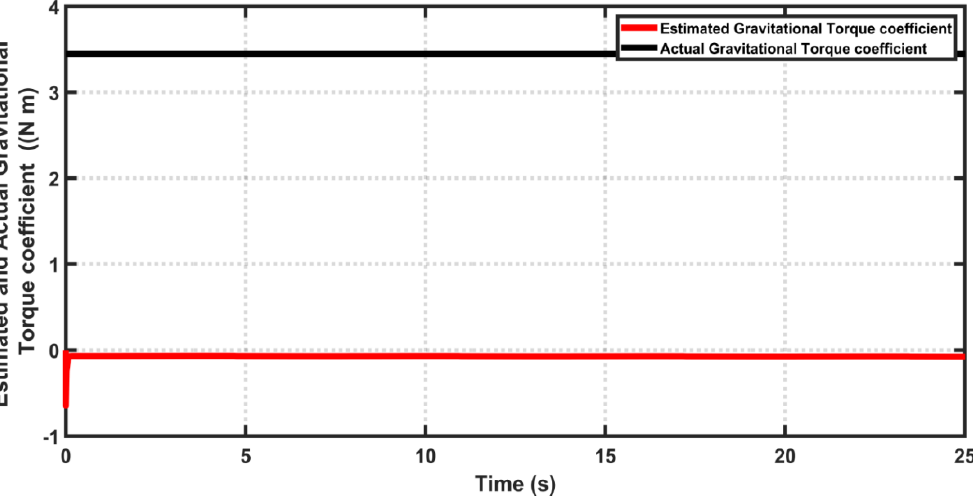
Figure 14. Behaviors of actual and estimated gravitational torque coefficients